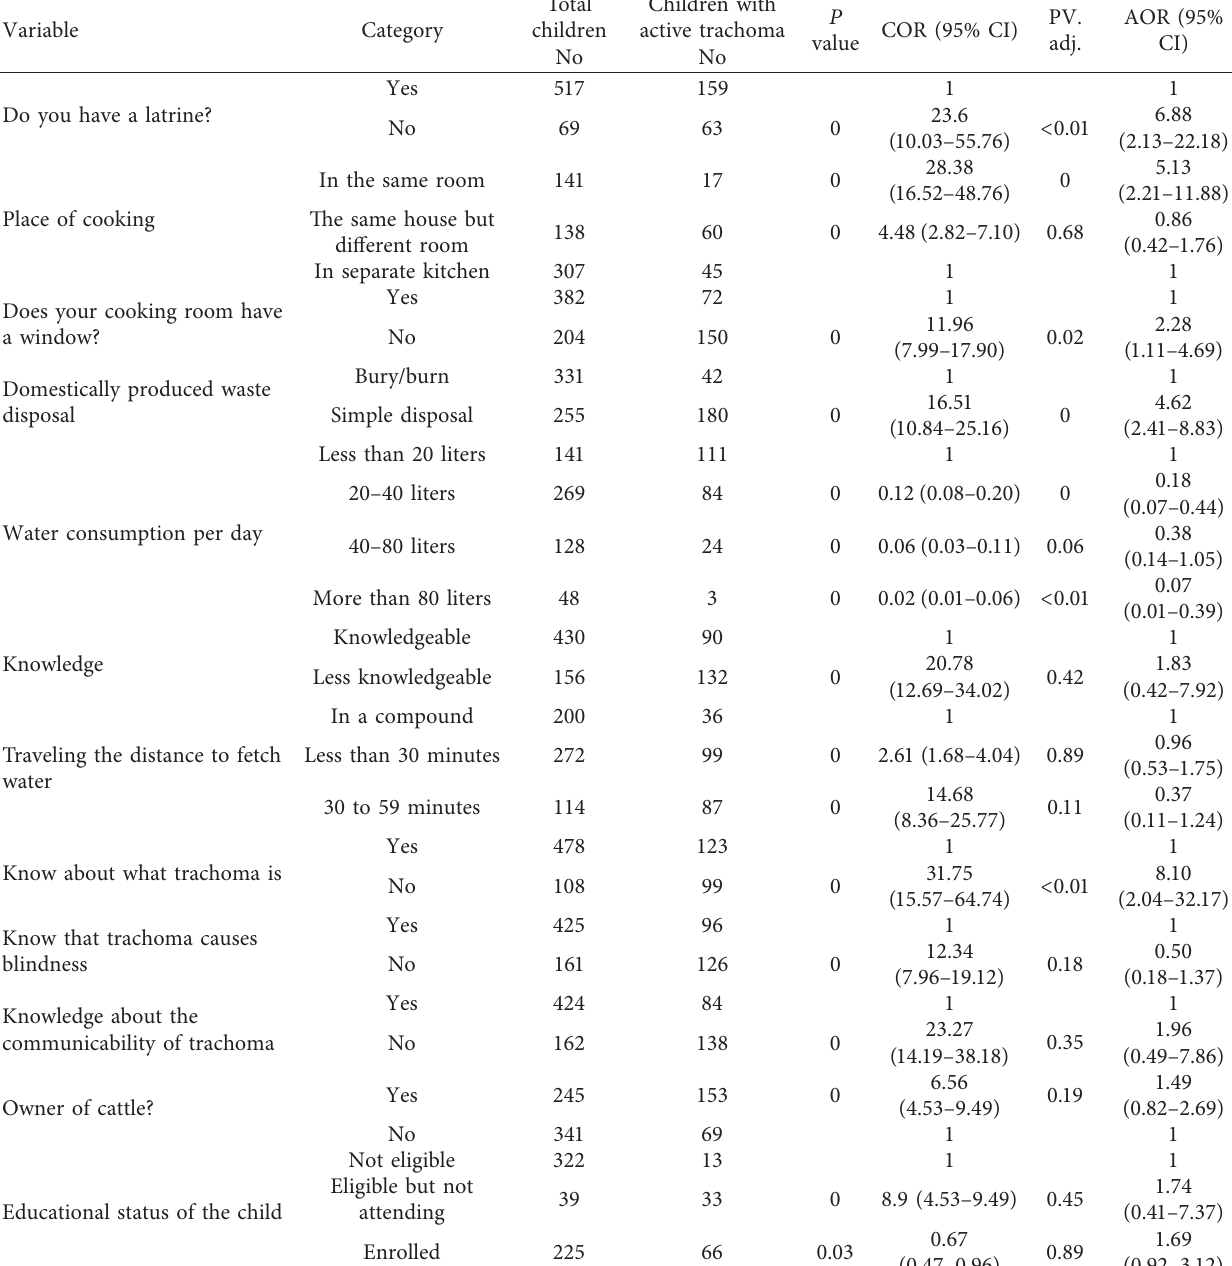
Table 4: Factors associated with prevalence of active trachoma in Areka Town in Southern Ethiopia, 2018 ( N � 586).